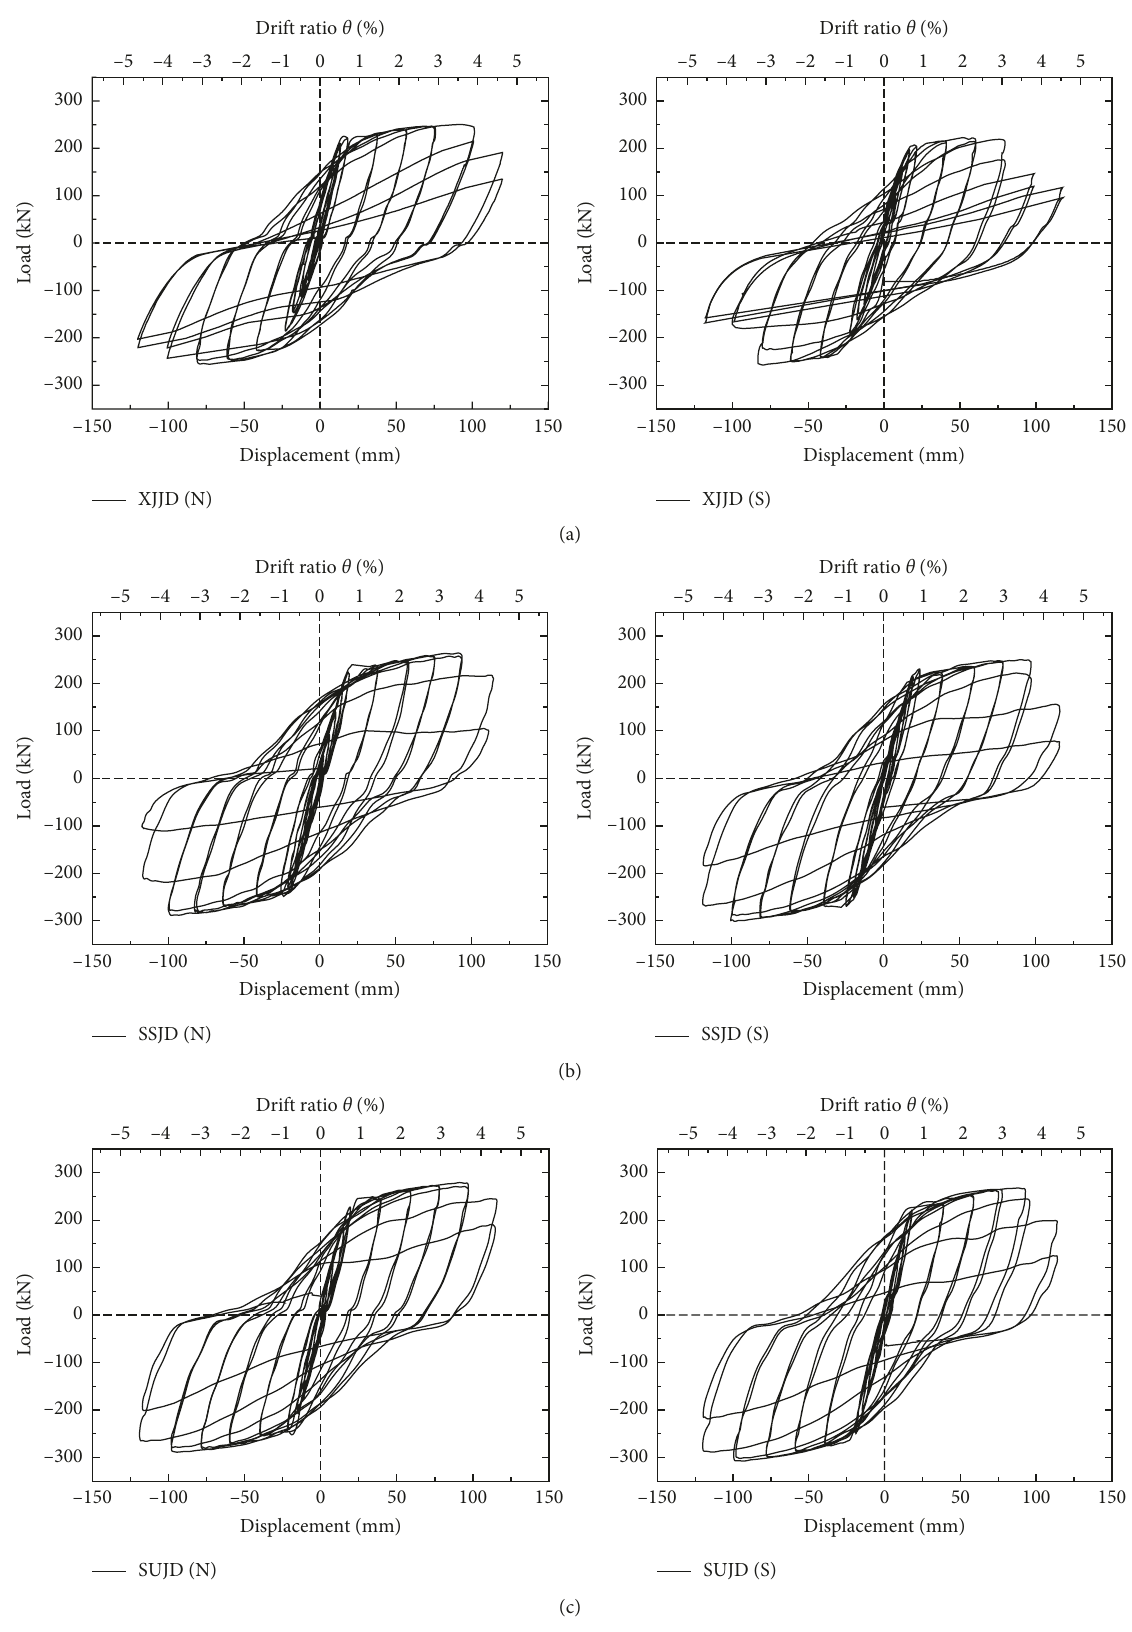
Figure 11: Load-displacement curves of specimens: (a) XJJD, (b) SSJD, and (c)